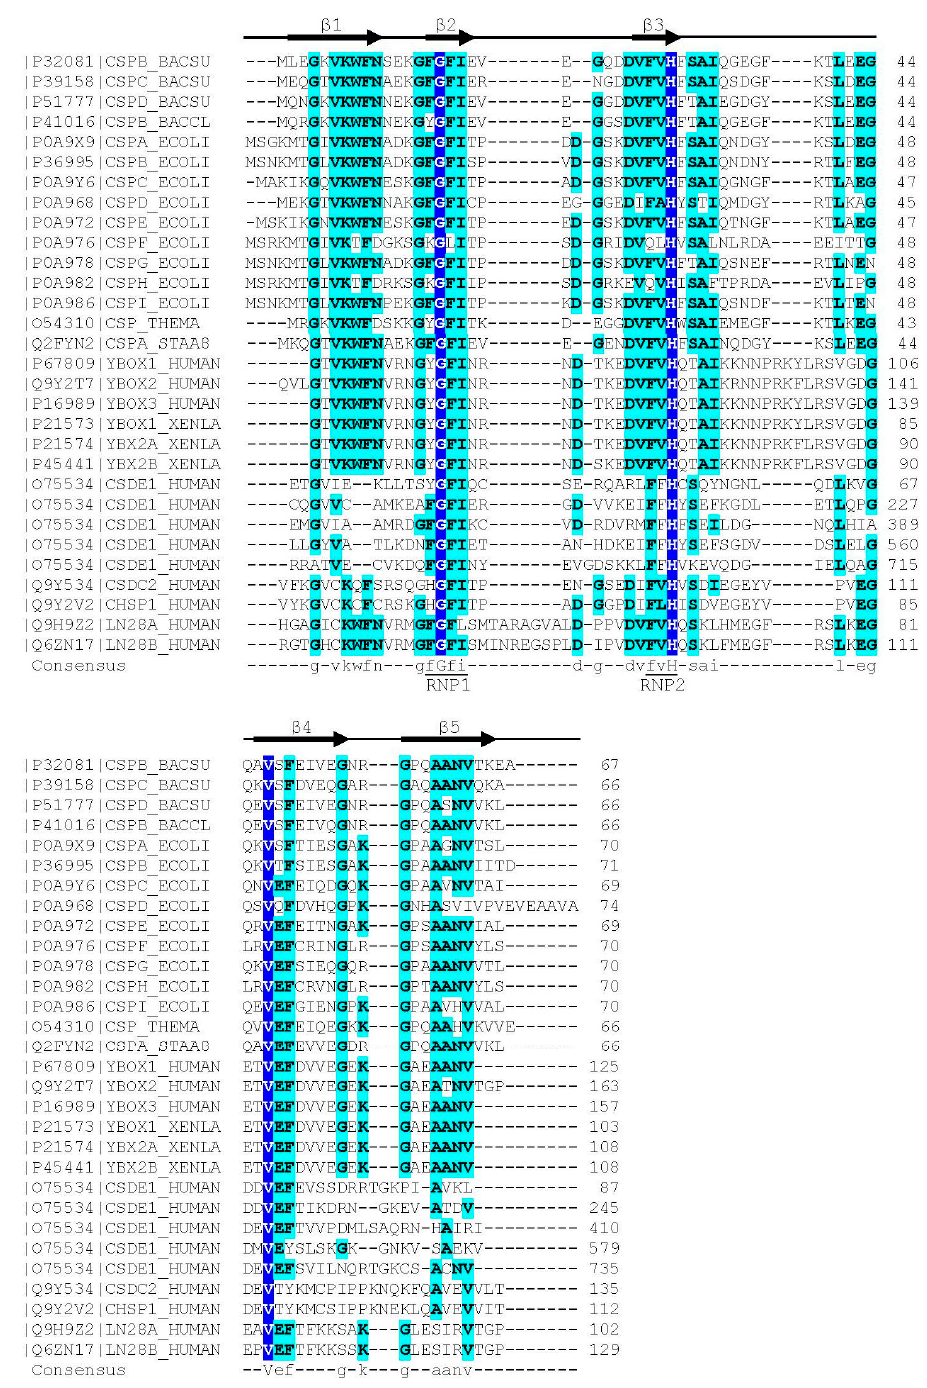
Figure 1. Sequence alignment of representative bacterial CSPs and CSDs from human proteins. The Xenopus laevis FRGY1 and FRGY2 (YBOX1, YBX2A, YBX2B) proteins are also included. Human CSDE1 contains five CSDs, all other proteins contain or consist of a single CSD. Proteins are identified by their Uniprot [22] entry number and name. The secondary-structure annotation atop the sequence follows Bs CspB, the first CSP for which a crystal structure was determined [23]. Residues conserved across all aligned CSDs are highlighted on dark blue background and shown with capital letters in the consensus sequence. Residues conserved in ≥ 50% of the sequences are shown on a light blue background and with lower-case letters in the consensus. Sequences were aligned using the Clustal Omega server [24]. The sequence motifs RNP1 ([YF]-G-F-I) and RNP2 ([YF]-[YF]-H) are associated with RNA binding and indicated according to Prosite [25].